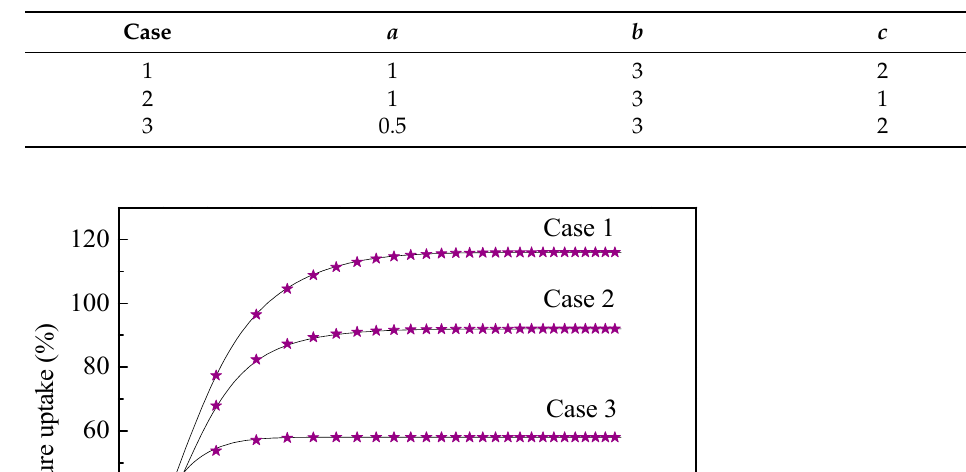
Table 3. The geometry parameters of the three cases for the unit cell.